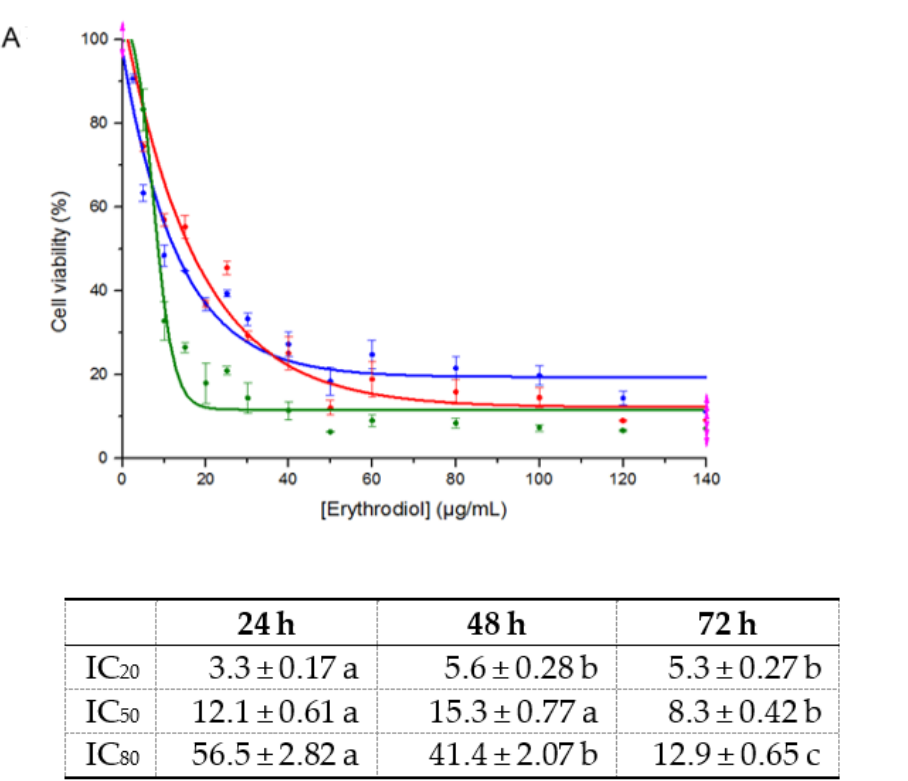
Figure 1. ( A ) Cytotoxicity curve of erythrodiol after HepG2 cells were exposed for 24 (blue), 48 (red), and 72 h (green). ( B ) IC 20 , IC 50 , and IC 80 values for the HepG2 lines after 24, 48, and 72 h of incubation with erythrodiol. In each row, significant differences ( p < 0.05) are expressed with different letters, a or b.